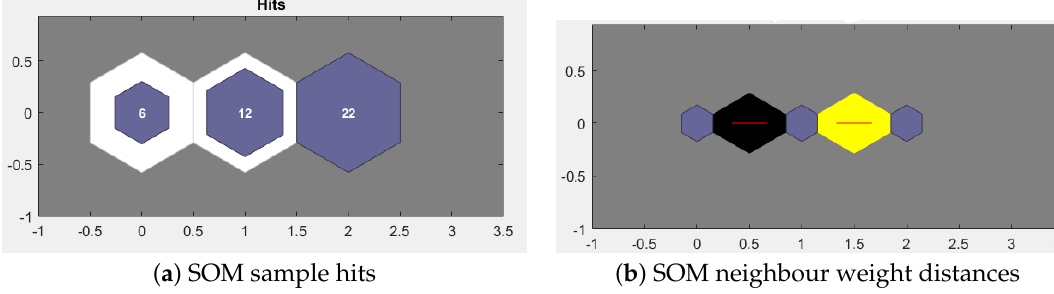
Figure 10. Results of the trained